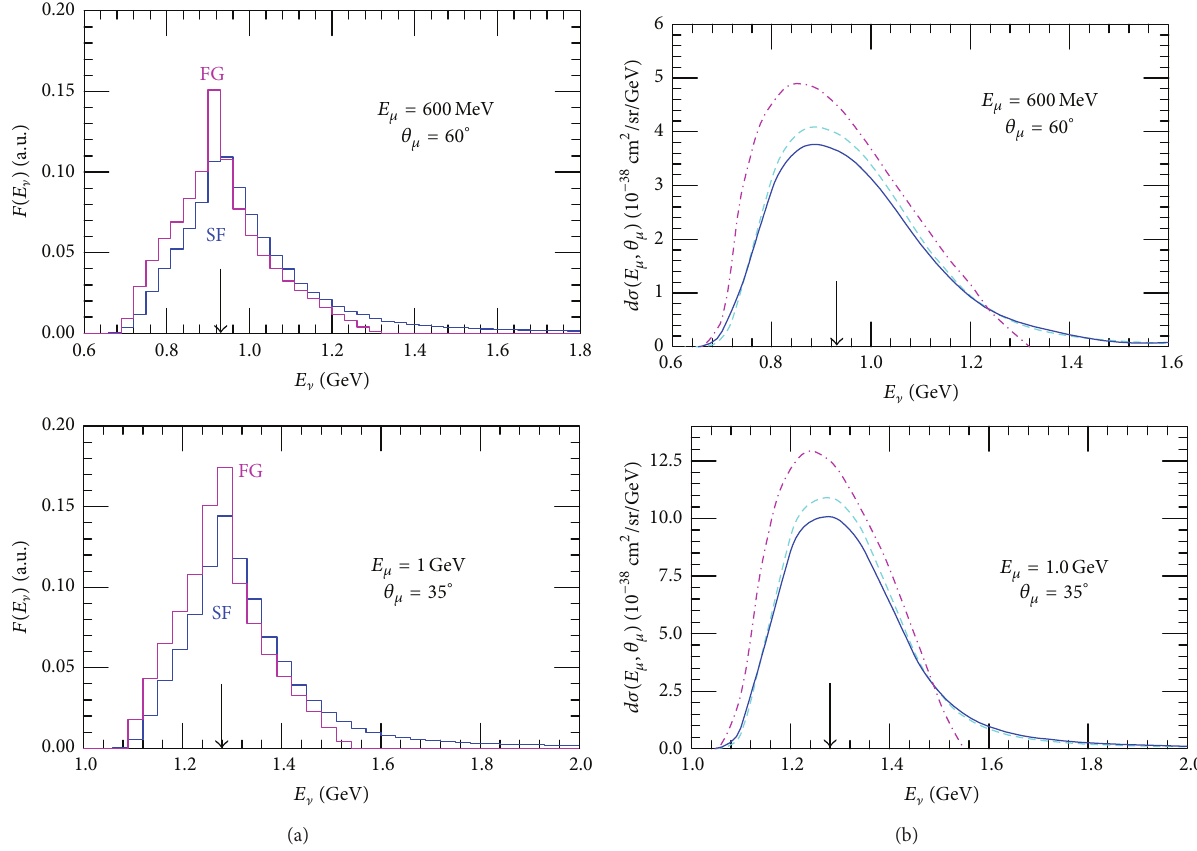
Figure 9: (a) Neutrino energy distribution at 𝐸 𝜇 = 600 MeV and 𝜃 𝜇 = 60 ∘ (upper panel) and 𝐸 𝜇 = 1GeV and 𝜃 𝜇 = 35 ∘ (lower panel), reconstructed from (45) using 2 × 10 4 pairs of ( | p 𝑛 |,𝐸 ) values sampled from the probability distributions associated with the oxygen spectral function of [49]. (SF) and the RFGM, with Fermi momentum 𝑝 𝐹 = 225 MeV and removal energy 𝜖 = 27 MeV (FG). The arrows point to the values of 𝐸 rec ] obtained from (46). (b) Differential cross-section of the process ] 𝜇 +𝐴 → 𝜇+𝑝+(𝐴−1) , at 𝐸 𝜇 = 600 MeV and 𝜃 𝜇 = 60 ∘ (upper panel) and 𝐸 𝜇 = 1 GeV and 𝜃 𝜇 = 35 ∘ (lower panel), as a function of the incoming neutrino energy. The solid line shows the results of the full calculation, carried out within the approach of [15, 52], whereas the dashed line has been obtained neglecting the effects of FSI. The dot-dash line corresponds to the RFG model with Fermi momentum 𝑝 𝐹 = 225 MeV and removal energy 𝜖 = 27 MeV. The arrow points to the value of 𝐸 rec ] obtained from